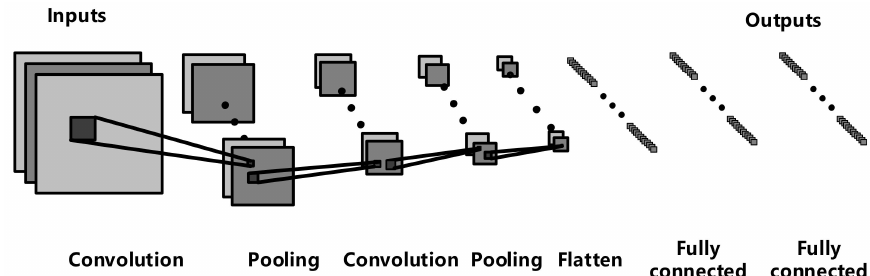
Figure 3. Network structure of